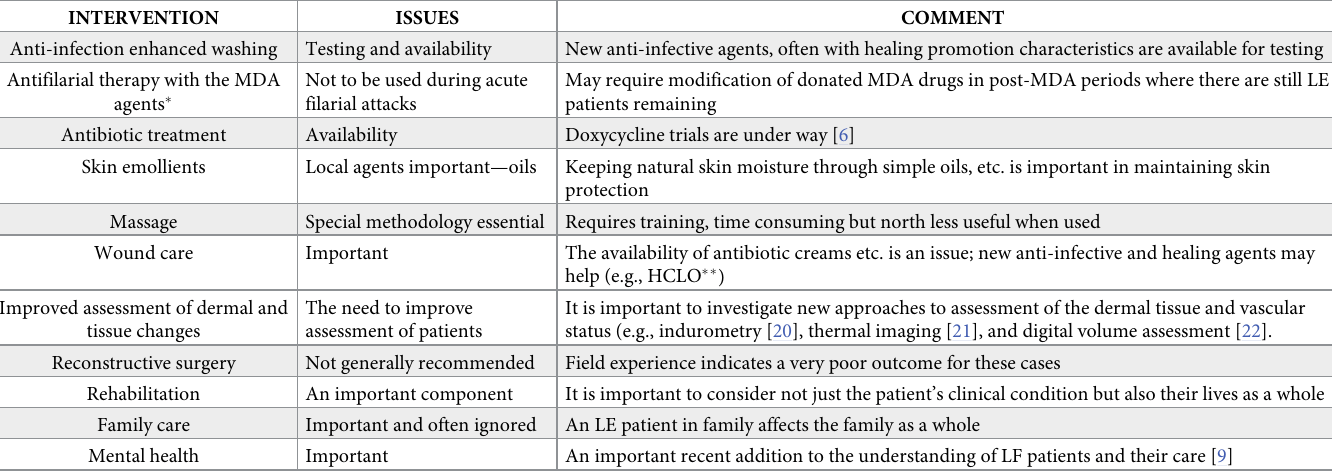
Table 1. Medical interventions additional to the WHO Minimal Care Package for filarial lymphoedema.